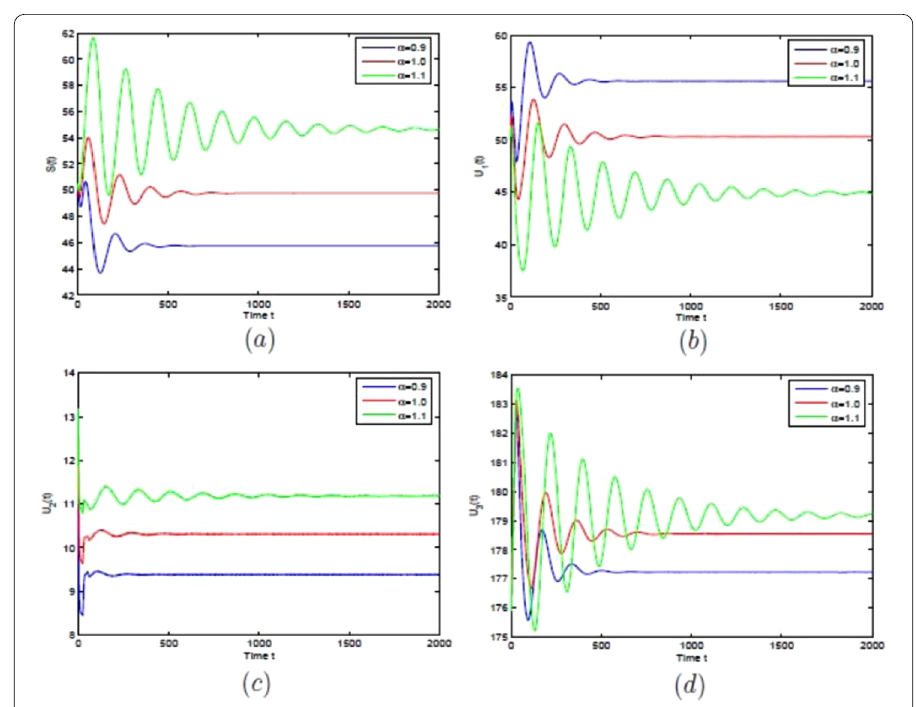
Figure 8 Effect of α on all classes for τ = 25.25: ( a ) S , ( b ) U 1 , ( c ) U 2 , ( d ) U